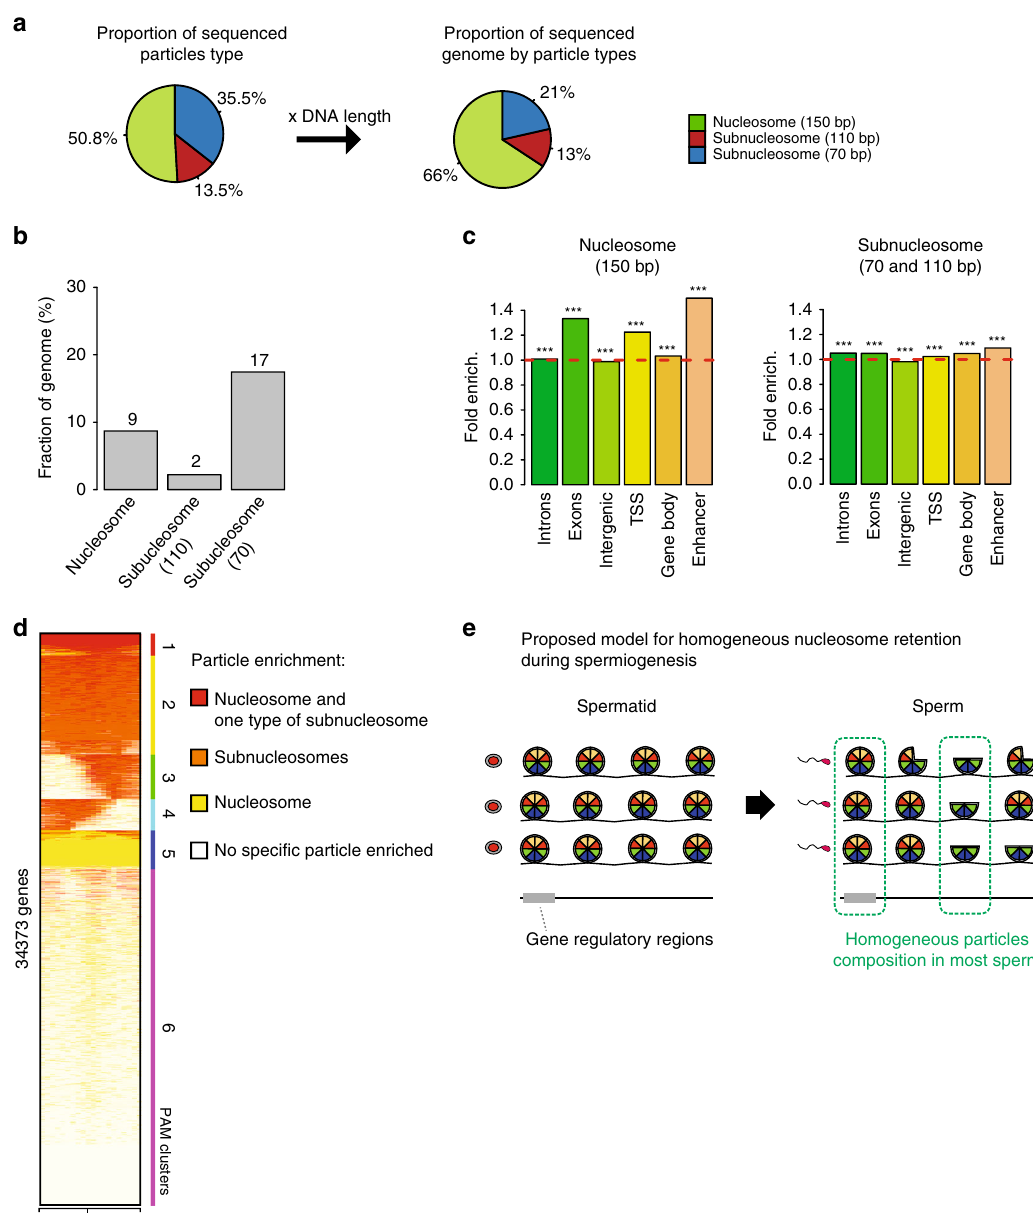
Fig. 2 Nucleosome loss/retention associated with spermiogenesis occurs non-randomly in a large fraction of the genome. a Relative abundance (left) and genome coverage (right) of nucleosomes and subnucleosomes in the sperm chromatin. The left pie chart reports the fraction of DNA fragments from Xenopus Laevis sperm corresponding to each type of particle; the right pie chart reports the fraction of genome covered by each type of particle. b Fraction of the genome with homogeneous particles composition. The bar graph indicates the percentage of the genome that possess nucleosomal or subnucleosomal structure across most sperm of the population sequenced (genome binned in 50 bp windows). c Fold enrichment (observed/random) over 1000 randomisations for homogeneous nucleosomes (left) or subnucleosomes (right) composition at the indicated genomic features; ***: empirical p value < 1e − 3. Input data from two independent replicates were pooled. d PAM (partitioning around medoids) clustering of promoter (TSS + / − 2 kb) according to enrichment for nucleosomes or subnucleosomes. e Model of nucleosomes and subnucleosomes distribution in sperm and spermatid. Source data related to a , b and d are provided as Source Data fi for H3 particle type and for H3 methylation, focusing on gene parameters are classi fi ed as either homogeneous or heteroge- regulatory regions (Fig. 4c and Supplementary Data 4). To that neous. Speci fi cally, histone methylation is considered homoge- end, we clustered all gene TSSs according to homogeneity for the neous if the bin has an HMD > 80%, and heterogeneous four H3 epigenetic parameters evaluated in this study (methyla- otherwise. In addition, a bin is classi fi ed as homogeneous for tion of H3K4, methylation of H3K27, nucleosome retention and the presence of a nucleosome or for subnucleosome if an nucleosome remodelling). The + / − 2 kb region around the TSS is enrichment is detected (two-layered inference strategy, see divided in 200 bp bins. For each bin, the four epigenetic M&M) and heterogeneous otherwise. In that way we obtain a